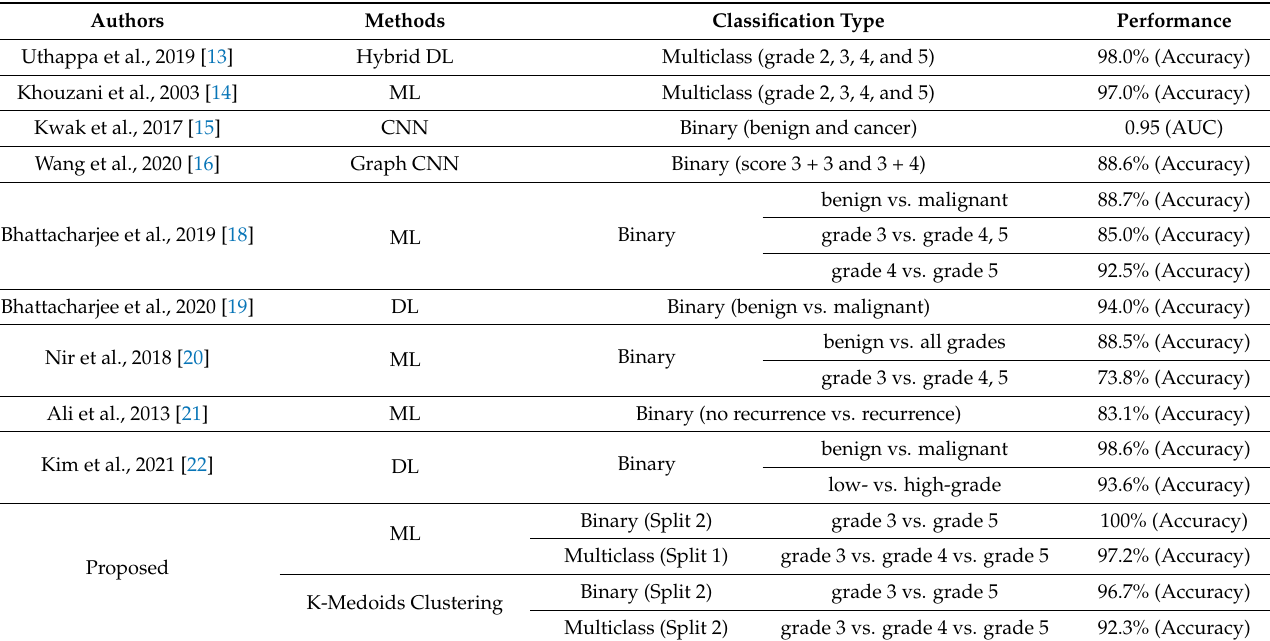
Table 4. Comparison with other state-of-the-art approaches. AUC: Area under the curve, DL: Deep learning, ML: Machine